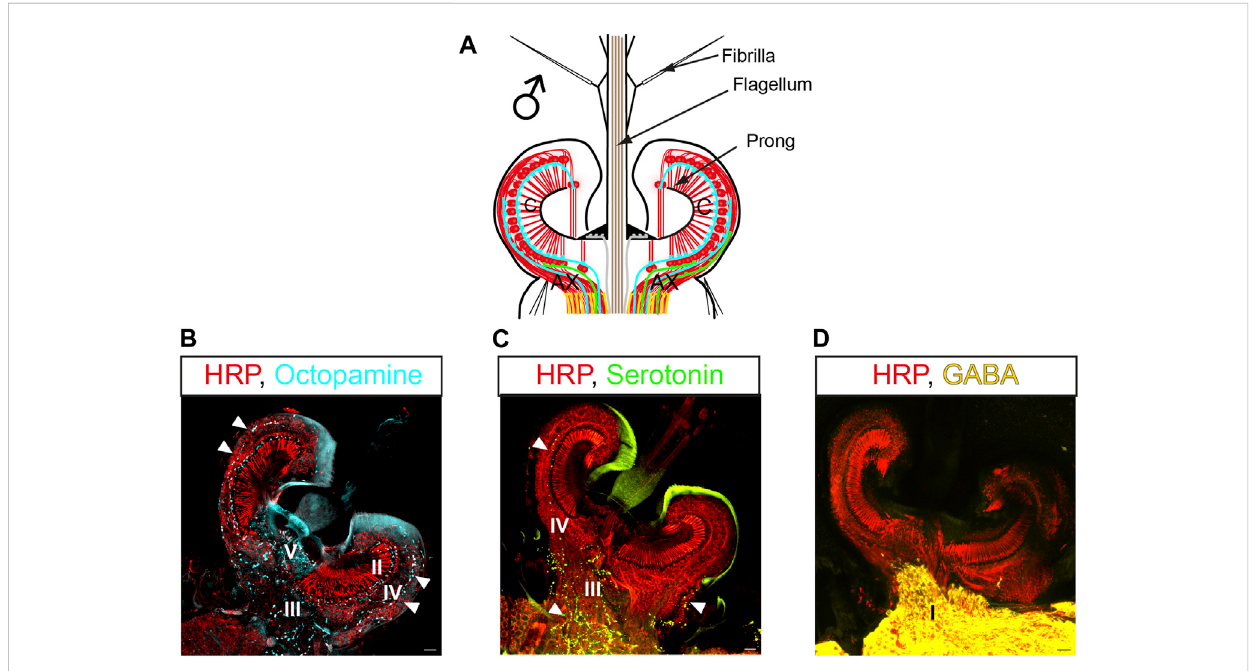
FIGURE 4 Pharmacology of the auditory efferent system in mosquitoes. (A) Schematic of a male JO and the efferent presynaptic terminals corresponding to the color coding in (B – D) ; efferent terminals shown as lines correspond to blue: octopamine, green: serotonin, yellow: GABA. (B – D) JO horizontal sectionsstainedwithantibodiesrecognizingdifferentneurotransmittersandcounterstainedwithaneuronalmarker(anti-HRP,red), (B) anti-octopamine (light blue, arrowheads); (C) anti-serotonin (green, arrowheads) and (D) anti-GAD (yellow, enzyme required for GABA synthesis). Letters in pictures represent the type of efferent terminals that release each neurotransmitter. Modi fi ed from (Andrés et al., 2016). AX: afferent axons; C: auditory cilia. Scale bar: 10